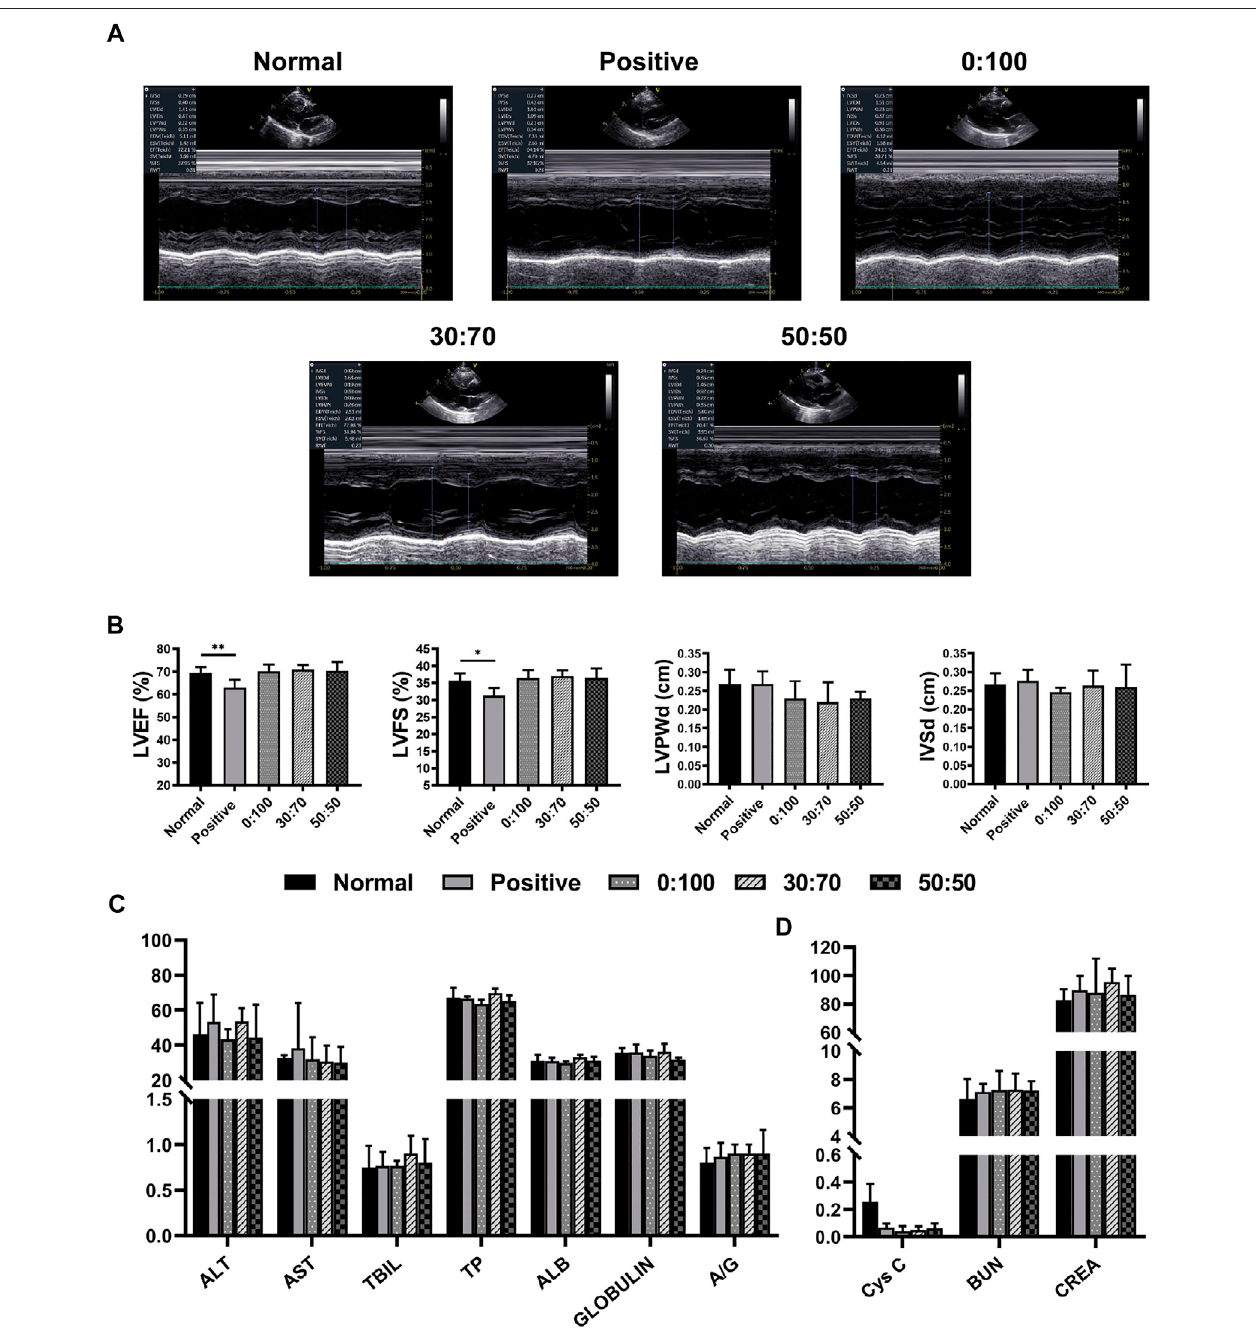
FIGURE8| Threemonthsaftersurgery (A) representativeechocardiographyimages, (B) heartfunctionand (C,D) liver/kidneyfunctionfornormalandexperimental groups. (* p < 0.05; ** p < 0.01).